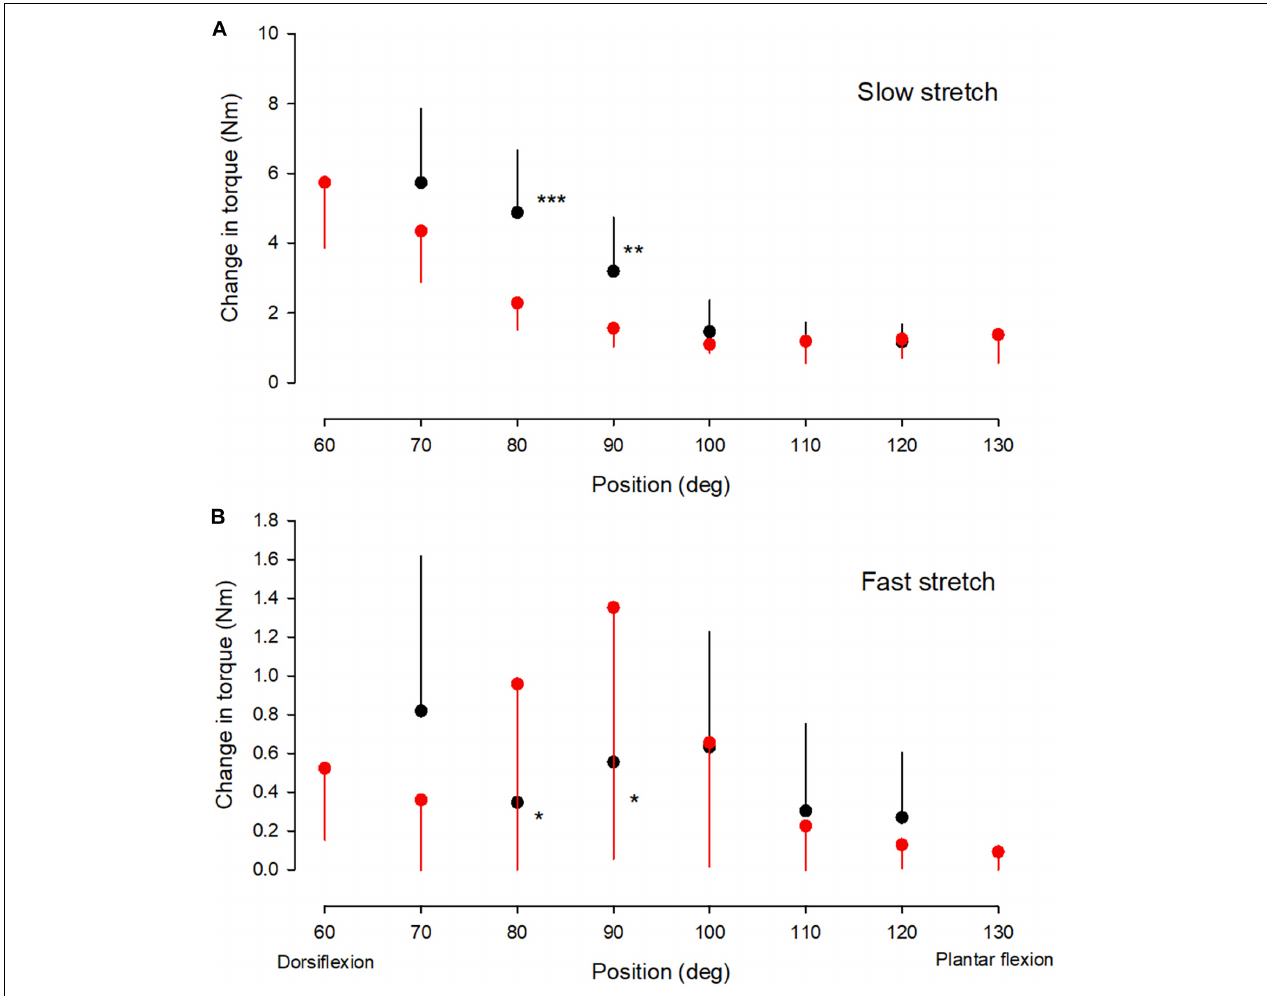
FIGURE 2 | Torque values. The change in passive torque (A) and reflex torque (B) of the ankle plantarflexor muscle-tendon unit at different ankle joint positions throughout the range of movement in the NI (red circles) and CP group (black circles). It was not possible to obtain measurements at joint positions of 60 and 130 deg in the majority of adults with CP and only measurements from the NI group are therefore shown for these two positions. It was possible to obtain measurements from 7 of the 13 adults with CP at 70 deg and these measurements have therefore also been included. For the remaining positions measurements were obtained from all subjects. Each symbol represents the mean of all measurements in each of the groups at the respective ankle joint positions. Each vertical bar is 1 SD. Statistically significant differences in measurements between the two groups are indicated by stars. * p < 0.05, ** p < 0.01, *** p <